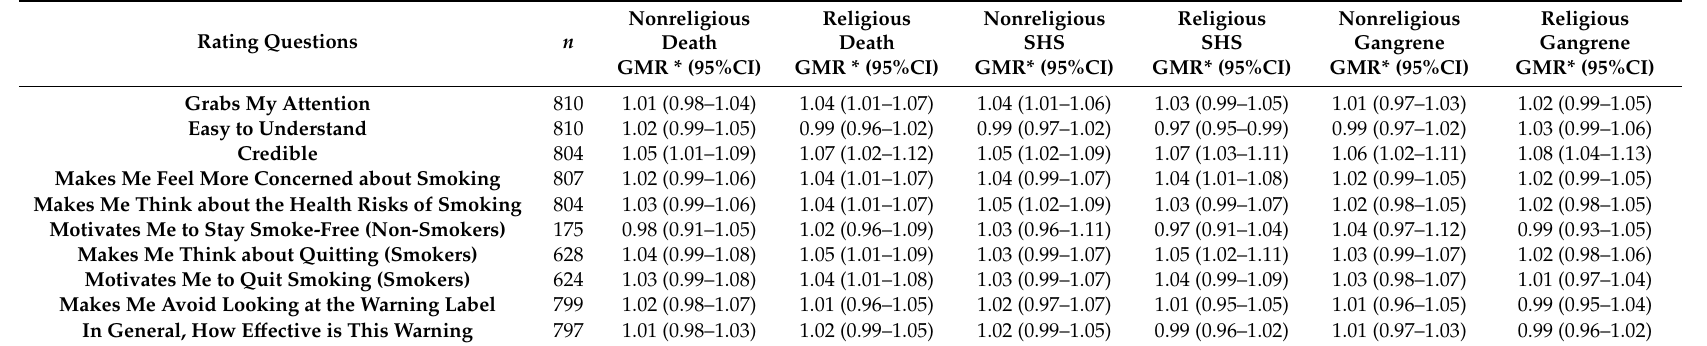
Table 4. Ratio of Geometric Means of Rating Questions by Centrality of Religiosity Score